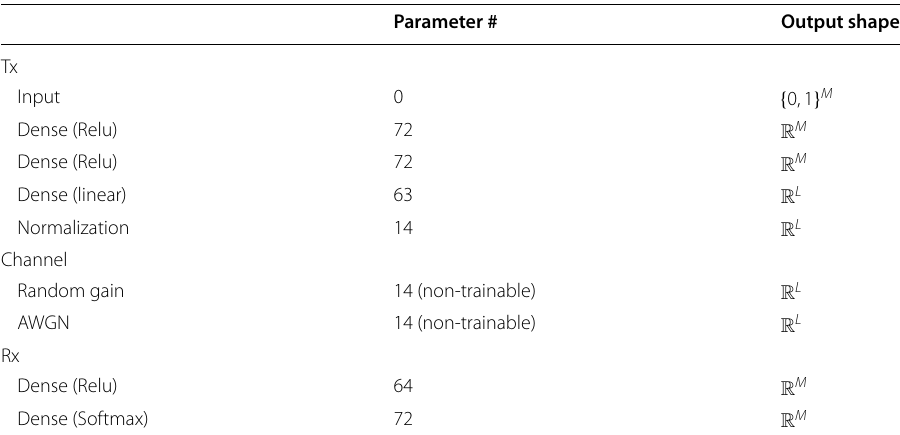
Table 1 Layout of autoencoder